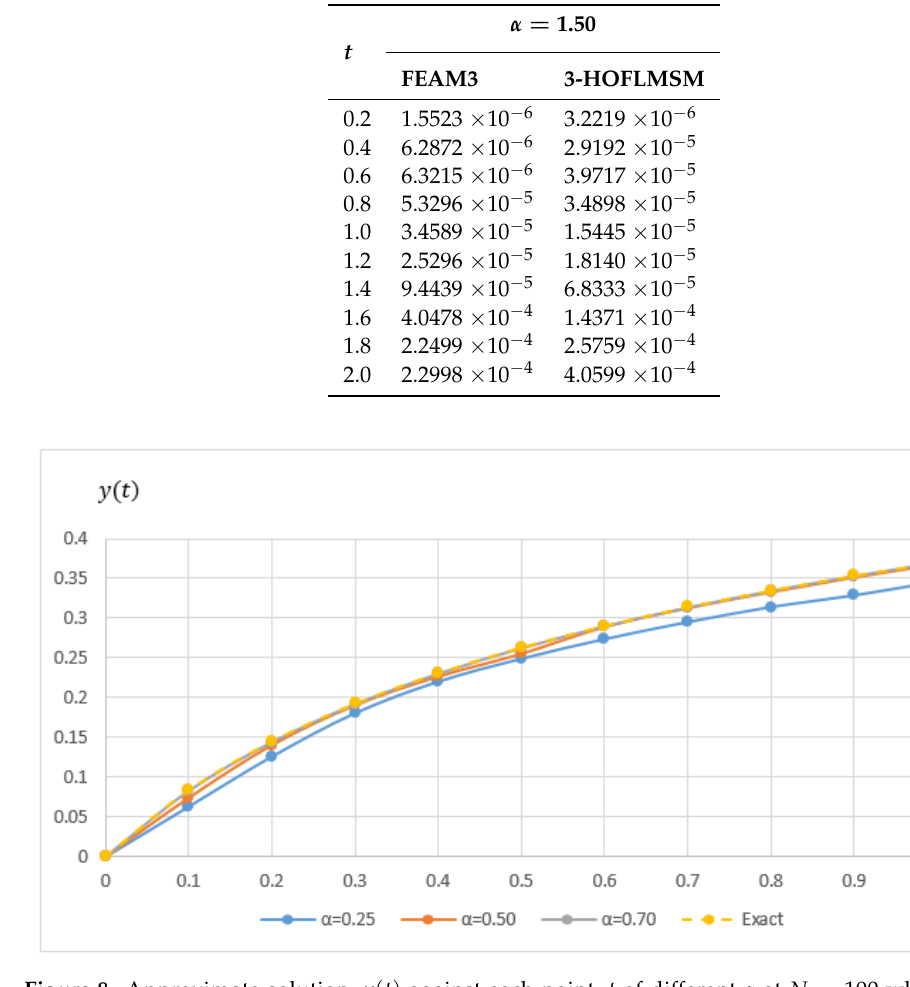
Figure 8. Approximate solution, y ( t ) against each point, t of different α at N = 100 when solving Example 4 using